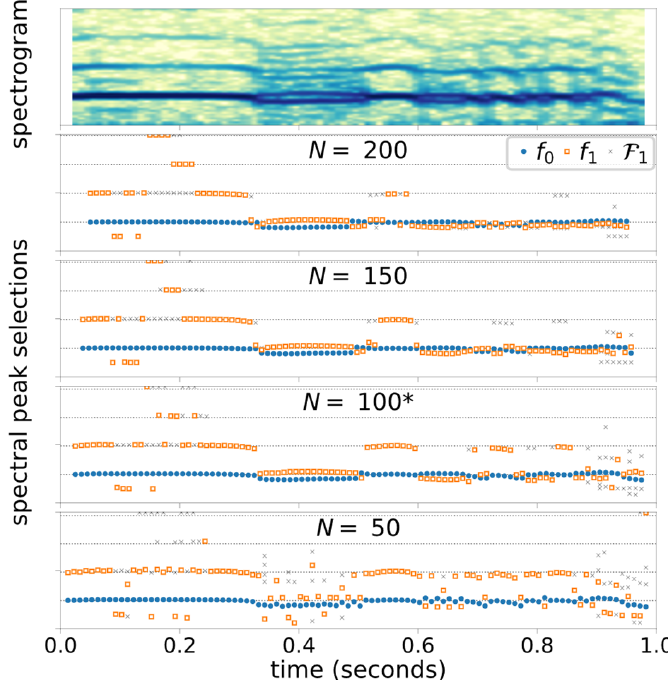
Figure 5. Case 3 Spectrogram (with 𝑁 = 100 ) and peak selection outcomes computed with four different window sizes, 𝑁 . Horizontal grid lines approximate the harmonic frequencies. * indicates the base configuration. (Time axes is shifted from other Case 3 plots for alignment.).